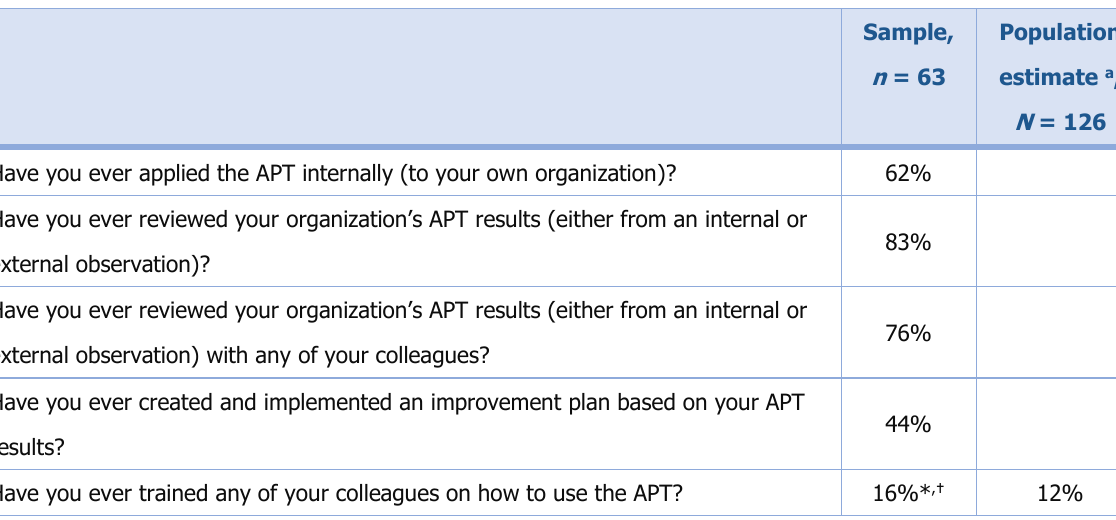
Table 4. Actual and Adjusted Impact on